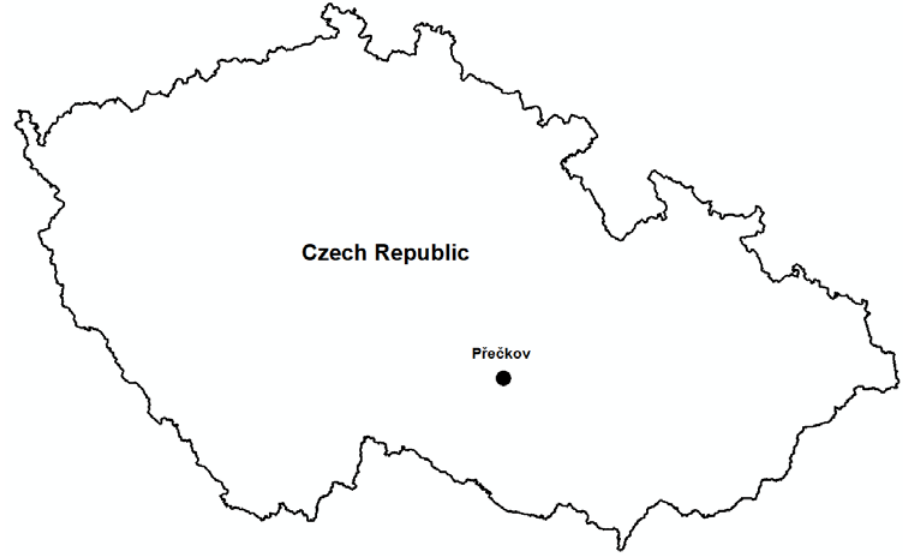
Figure 1. Location of Přečkov within the Czech Republic.